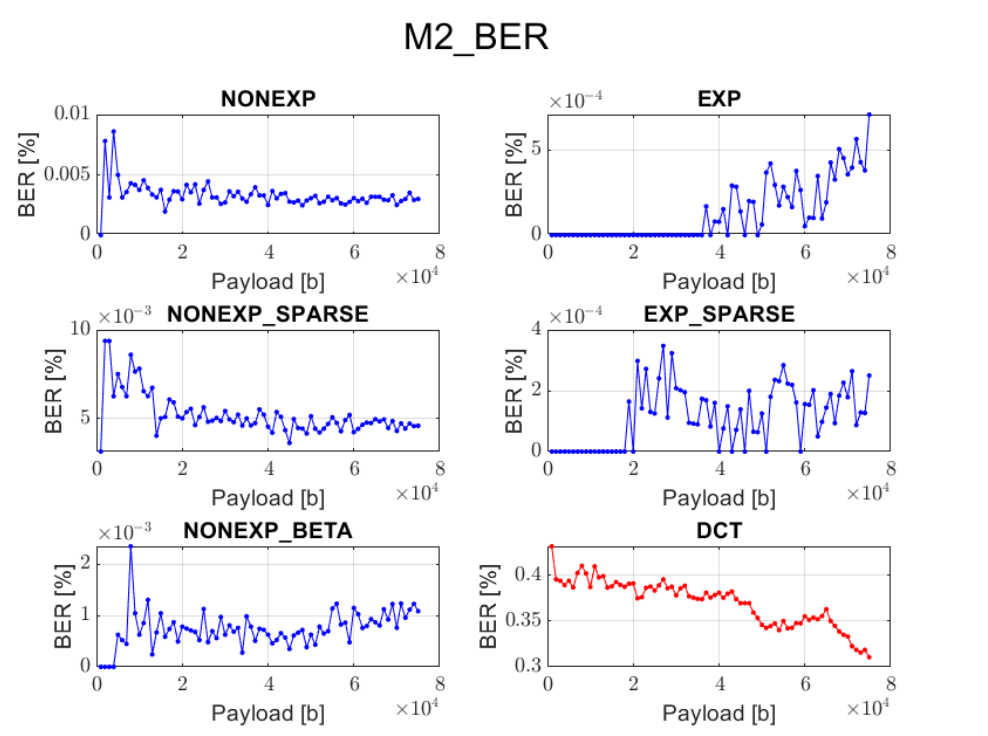
Figure 8. Relation between BER and embedded data size for method 2 and all transform types.